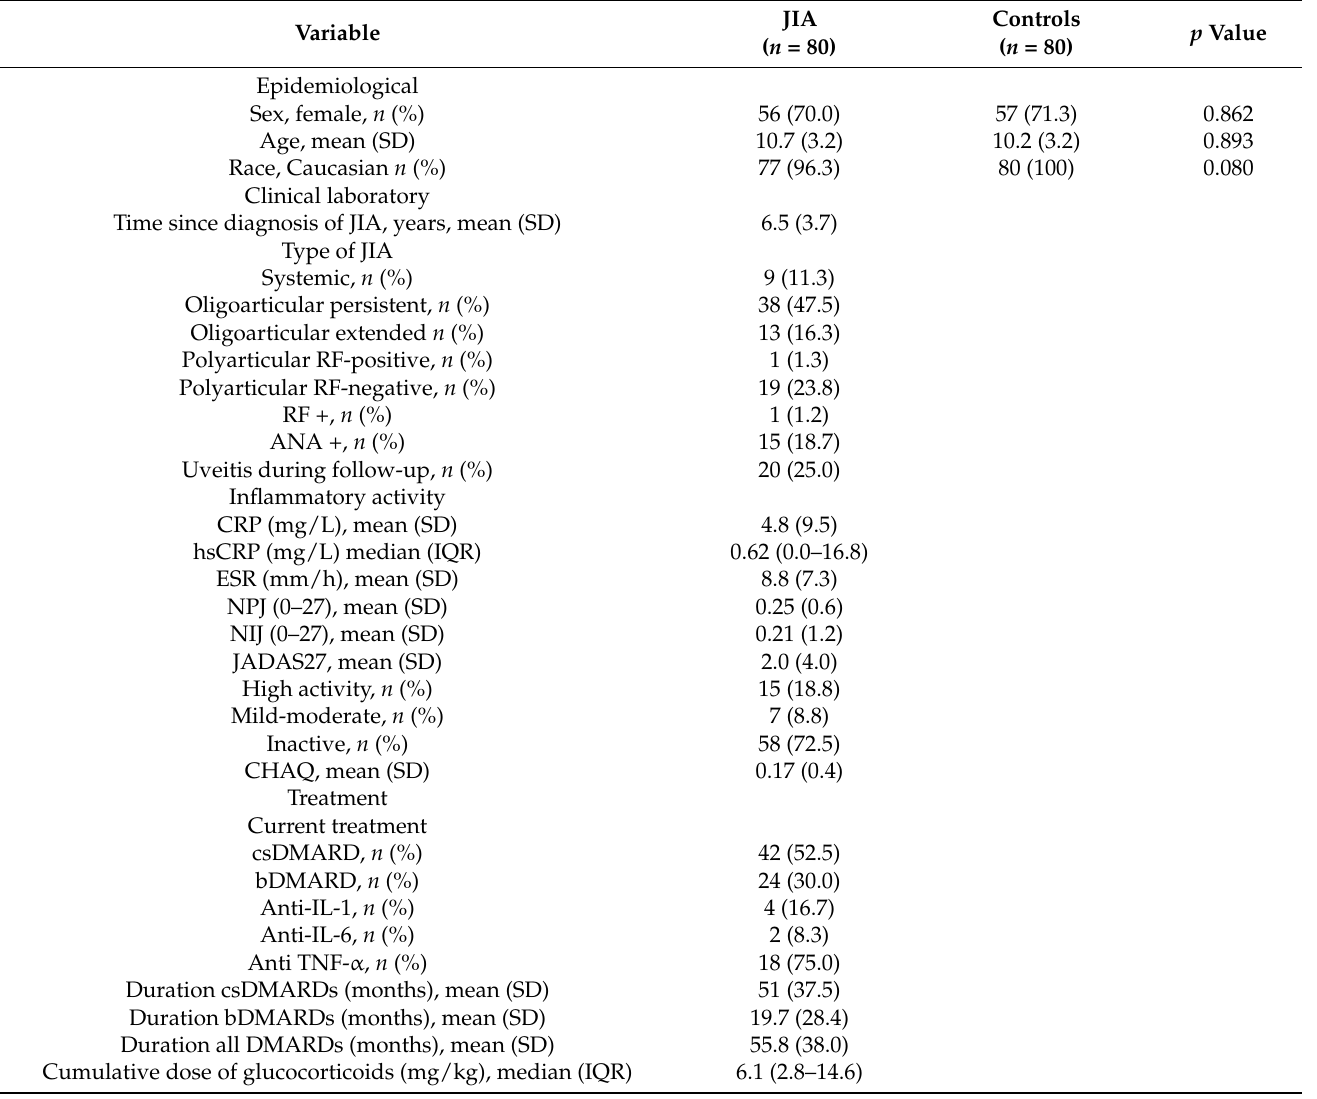
Table 1. Characteristics of patients with JIA and controls on the reference date and during follow-up.